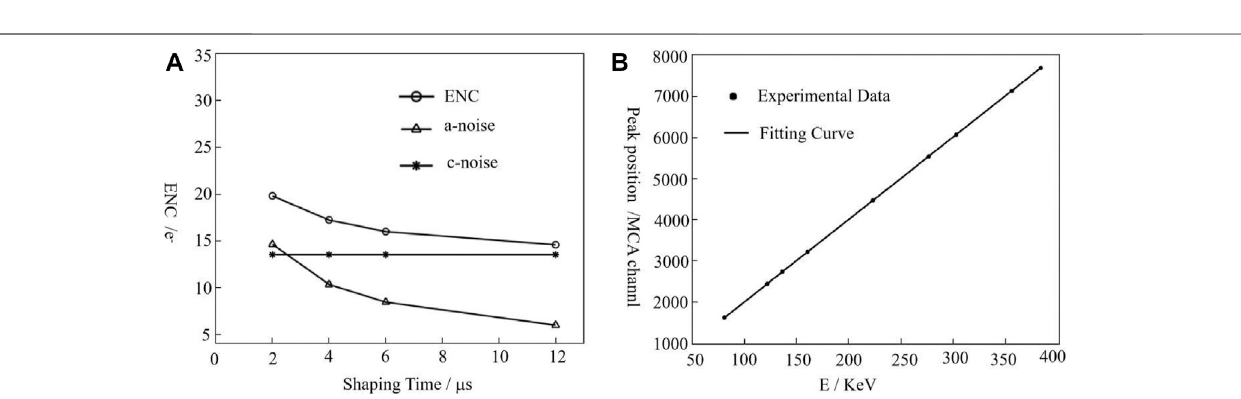
FIGURE 8 | Noise analysis of the preampli fi er circuit.